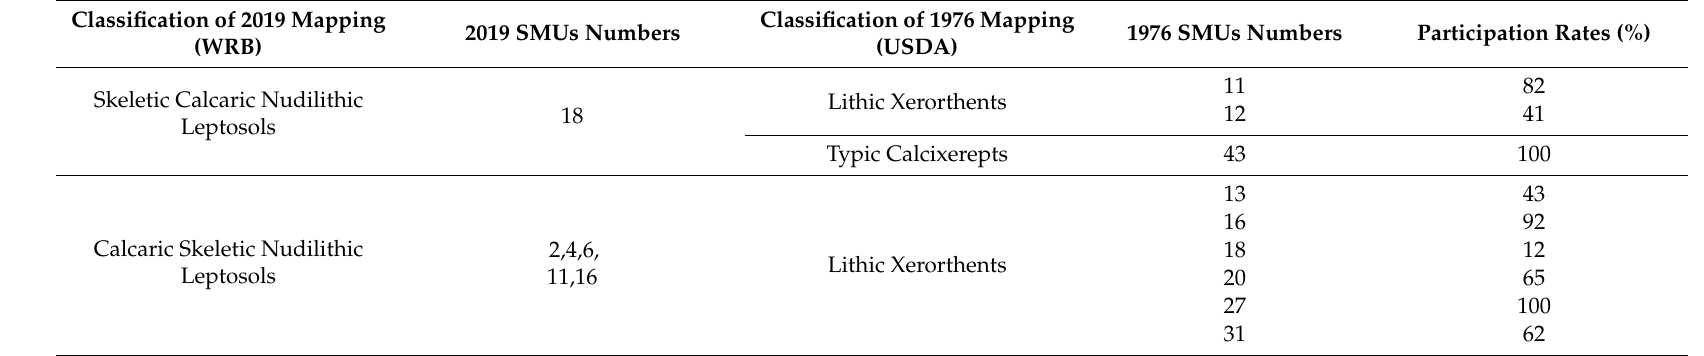
Table A11. Table of the participation rates of 1976 SMUs area to the classification of 2019